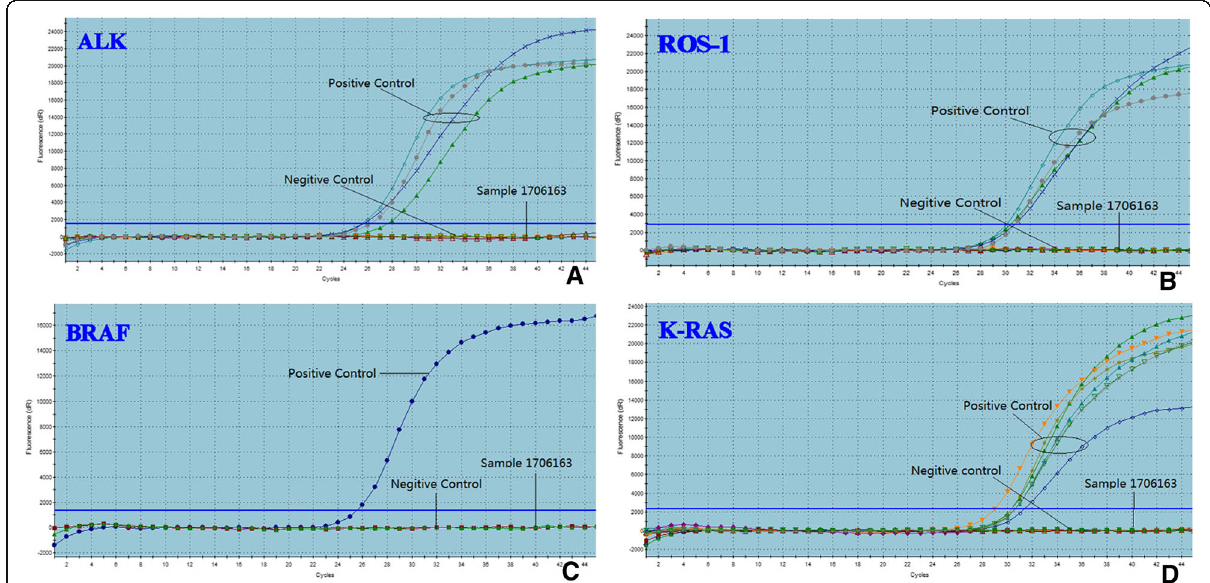
Fig. 4 The genetic features of MTC without melanin production. There were no mutation and gene fusion in this